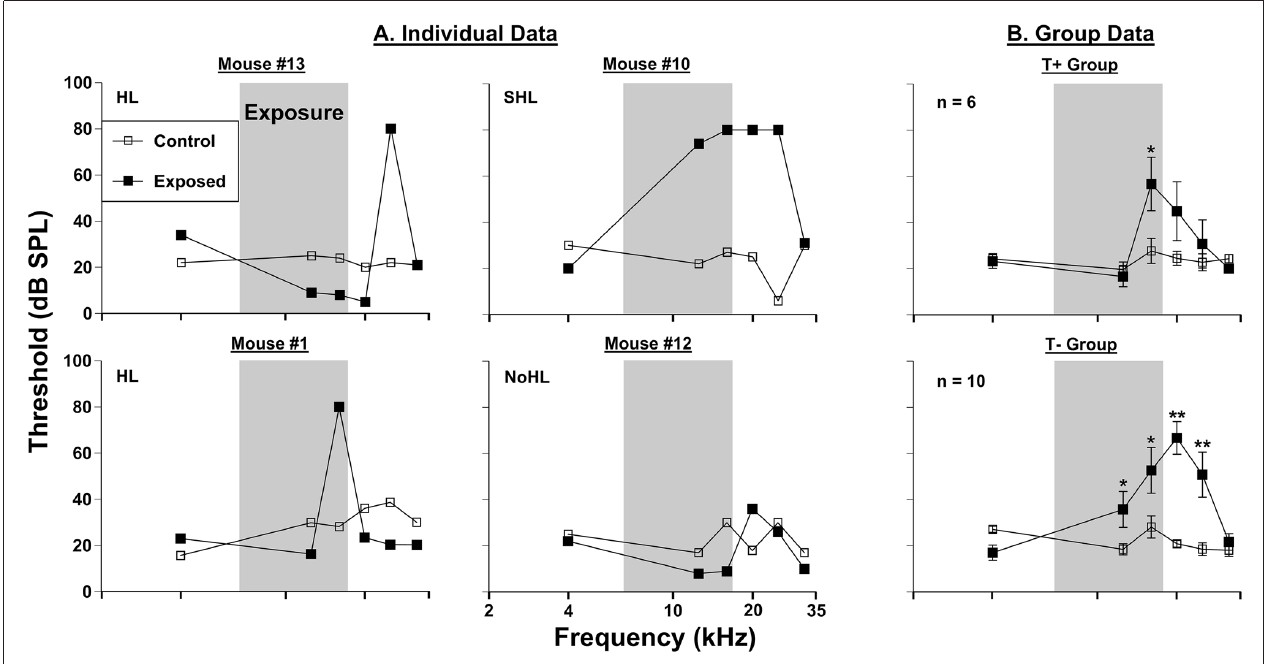
FIGURE 2 | Auditory thresholds assessed via prepulse inhibition (PPI) audiometry. (A) Four individual mice were tested before (control) and 3 months (exposed 3M) after sound exposure. (B) Group PPI data for T+ mice ( n = 6) and T − mice ( n = 10; from Figure 1B ), in the same conditions as (A) . The narrow band exposure stimulus is represented by a gray box. Each animal was classified as having hearing loss (HL), severe hearing loss (SHL), or no hearing loss (NoHL) based on the number of frequencies at which PPI thresholds were elevated. Significant threshold shifts indicated with ( ∗ ) at p = 0.05 level or ( ∗∗ ) at p = 0.001